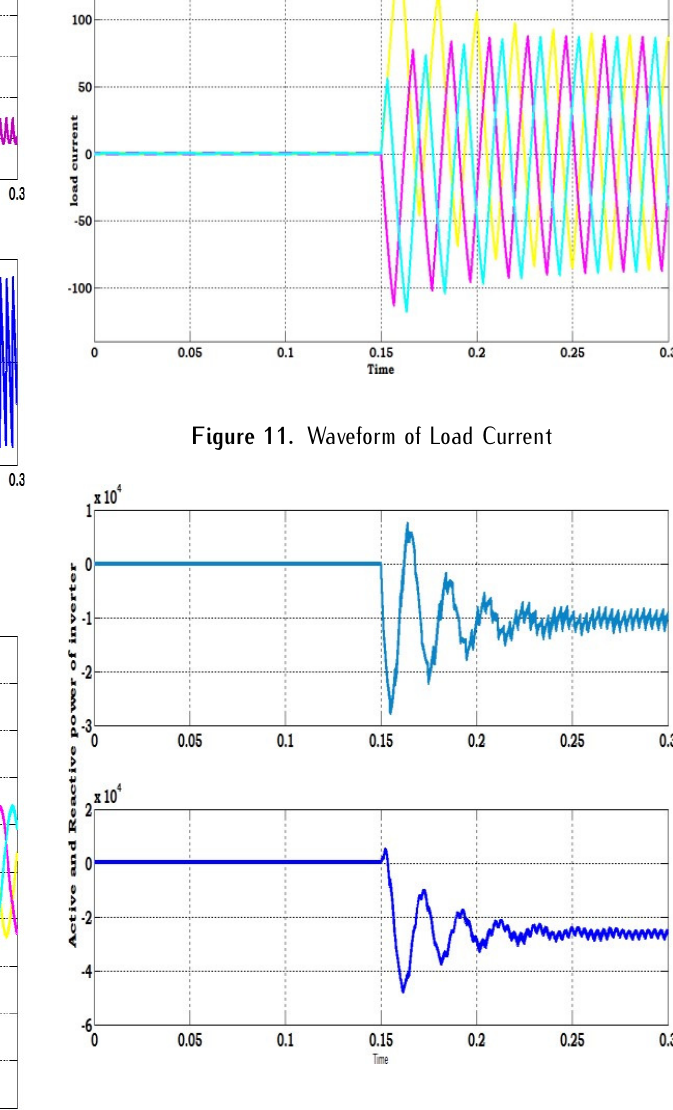
Figure 12. Waveform of Active and Reactive Power of Inverter of DG system at t=0.15s, it was maintained at 1000W, 2500VAR showing injection of